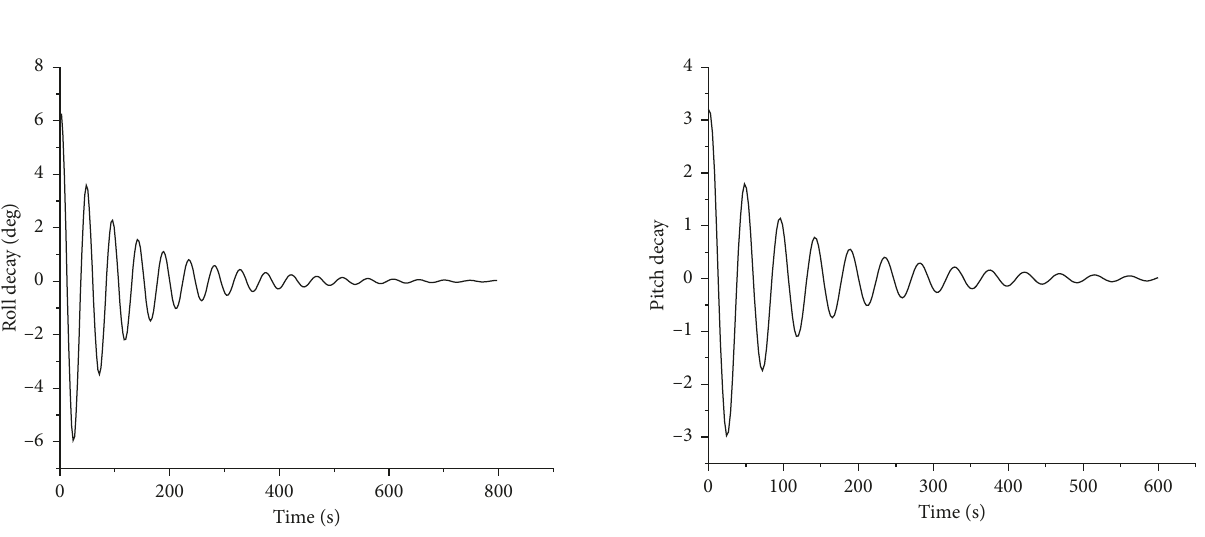
Figure 11: Decay curve of roll motion.